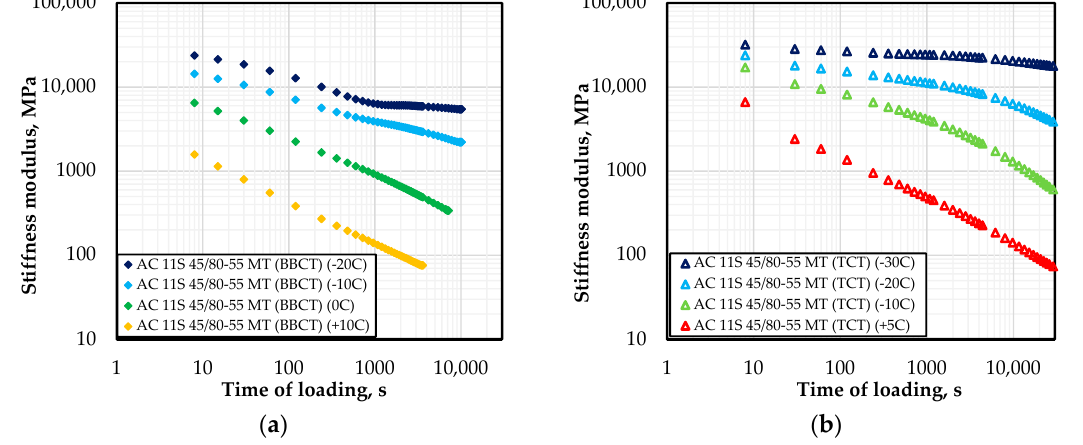
Figure 9. Creep test results—stiffness curves for AC 11S 45/80-55 MT ( a ) BBCT; ( b ) TCT.